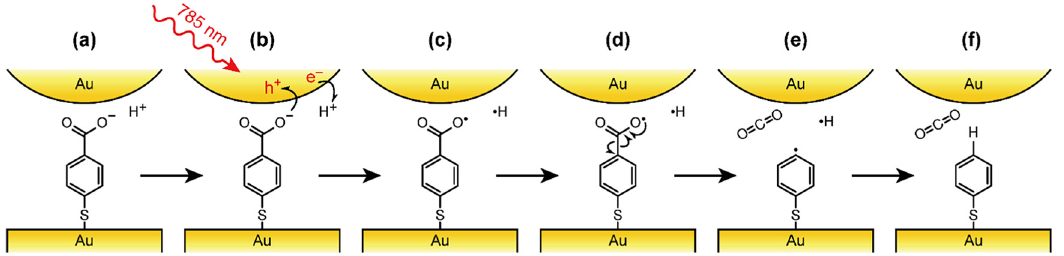
Figure 4: Mechanism of the plasmon-driven scissoring reaction proposed by Yoon group. Hot holesfrom Au-coatedtip are transferredto carboxylateanion of 4-MBA(a-b),whilehotelectronsare transferredto protons, leadingto the formation of carboxyl radicals and hydrogen atoms (c-d). The radicals then undergo intermolecular rearrangement that leads to the C-C bond cleavage (e-f)